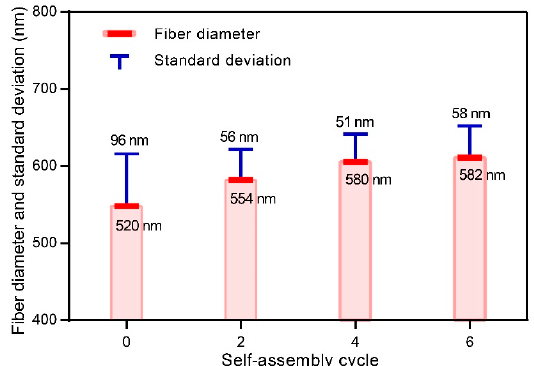
Figure 3. Fiber diameters and standard deviations of TiO 2 -coated electrospun fibers with different self-assembly cycles.